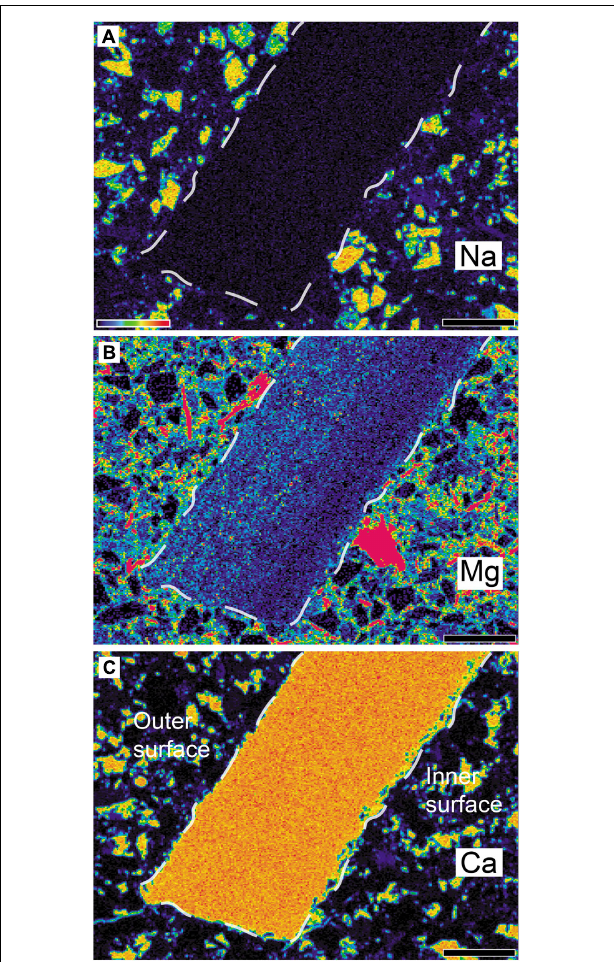
FIGURE 4 | Elemental composition of Aenigmaoolithus vesicularis oogen. et oosp. nov. (SNUVP 201704) and its surrounding matrix. (A) Na is nearly absent in the eggshell, whilst it is present in the matrix. (B) The concentration of Mg is somewhat higher in the outer half while it is nearly absent in the inner half. Mg is also highly enriched in the matrix. (C) The concentration of Ca is very high in the eggshell as well as some parts of the matrix. A colored-bar in (A) shows the intensity of the signal with red represents a stronger one. Note that the panels do not share absolute concentration scale. The eggshell boundaries are marked by white dashed lines. All scale bar equals 100 µ